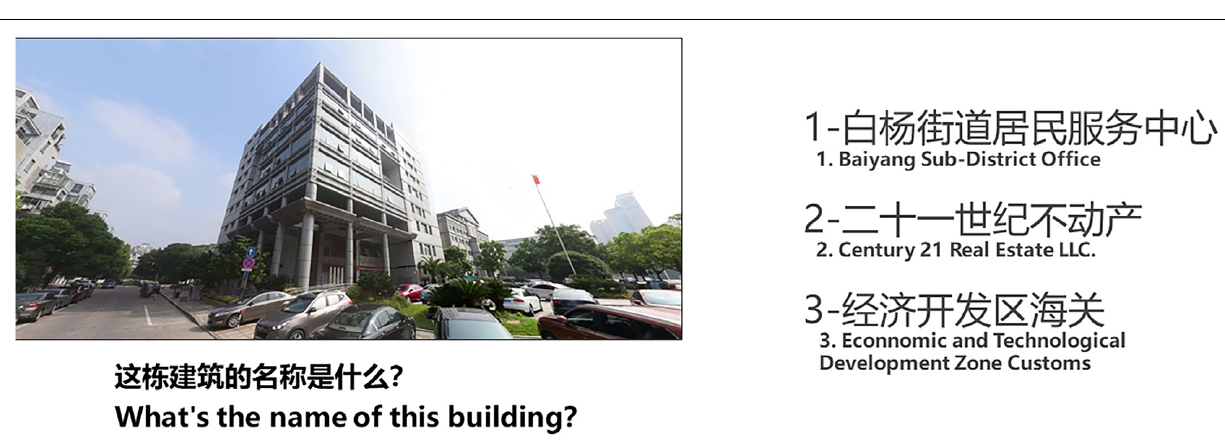
FIGURE 6 | Scene recognition task: Task